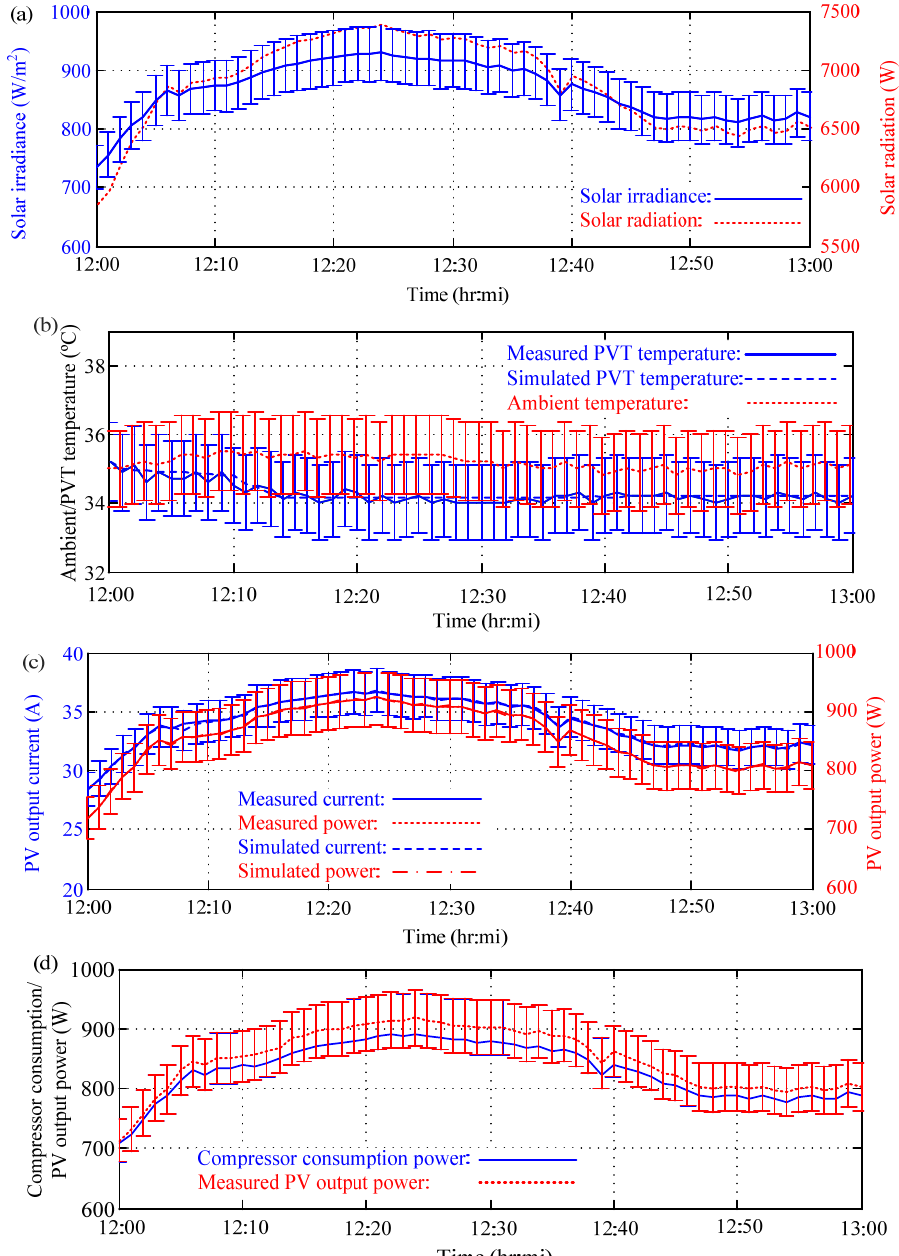
Figure 6. Measured and simulated data on a typical sunny day (18 June 2013): ( a ) Solar irradiance and radiation; ( b ) Ambient and PVT temperatures; ( c ) Measured and simulated PV output current and its power; ( d ) Compressor power and measured PV output power; ( e ) Measured and simulated water temperature and storage